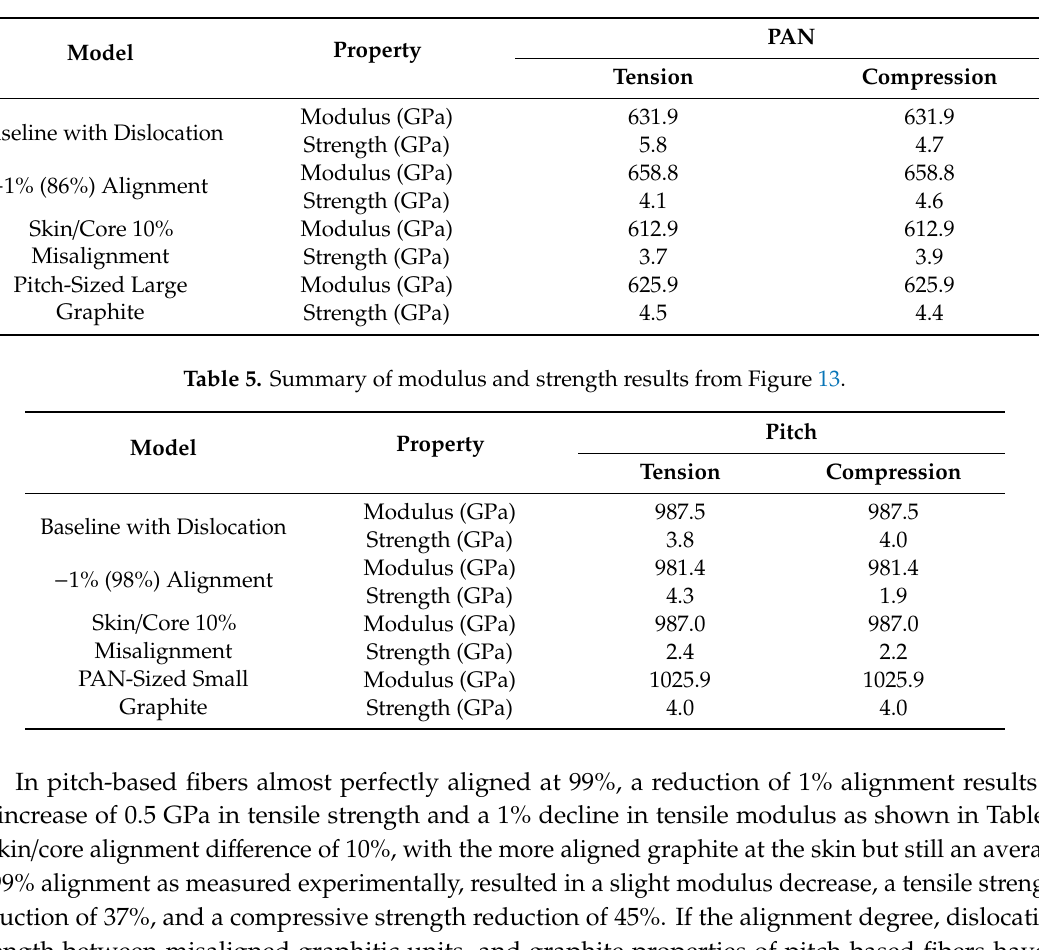
Table 4. Summary of modulus and strength results from Figure 12.